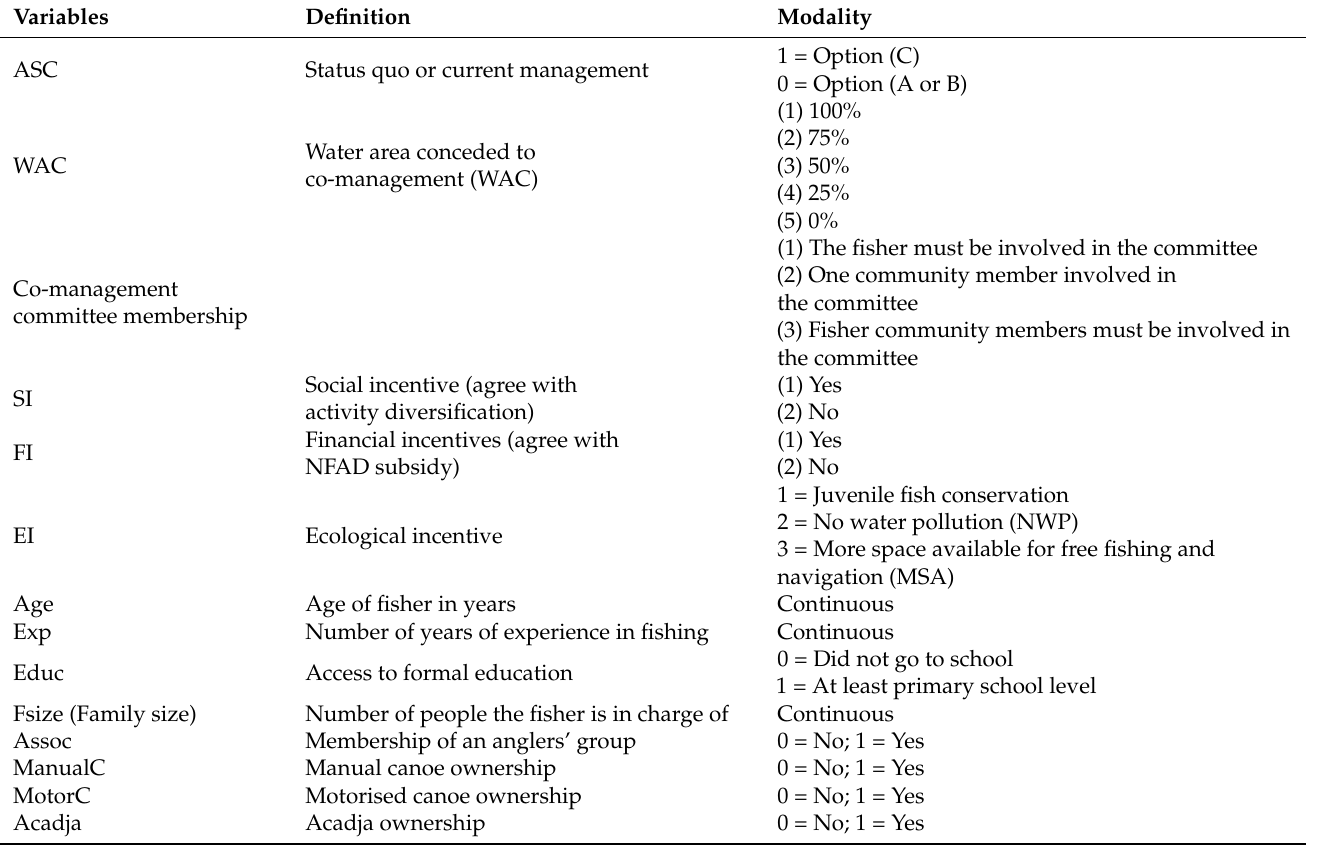
Table 3. Definition of the socio-economic variables in the interaction model.